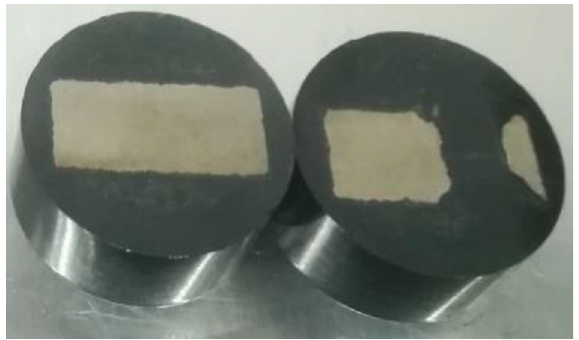
Figure 8: Specimen c (a) and a (b) mounted in bases of